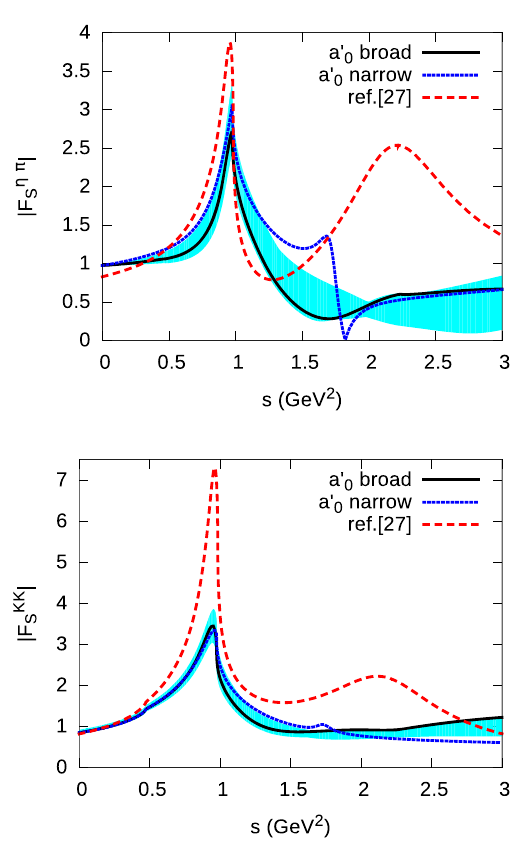
Fig. 11 Absolute values of the scalar form factors: the results using the sets of T -matrix parameters from the two different fits to the γγ data are compared with a typical result from Ref. [27]. The bands are obtained by varying the intrinsic parameters as in Table